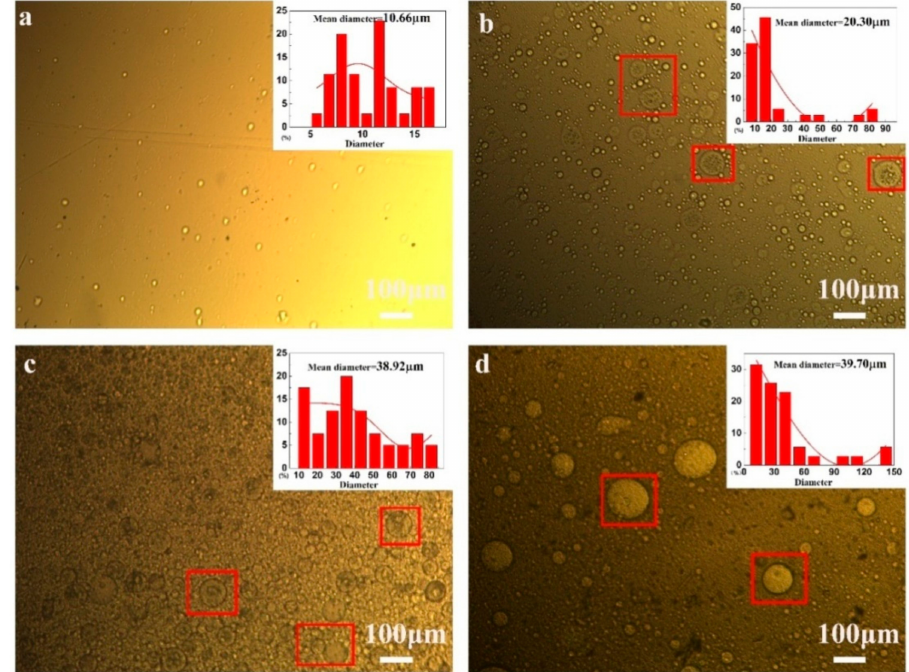
Figure 2. Emulsion with di ff erent contents of emulsifying agent: ( a ) 5.0 wt% SDBS; ( b ) 10.0 wt% SDBS; ( c ) 15.0 wt. % SDBS; ( d ) 20.0 wt%